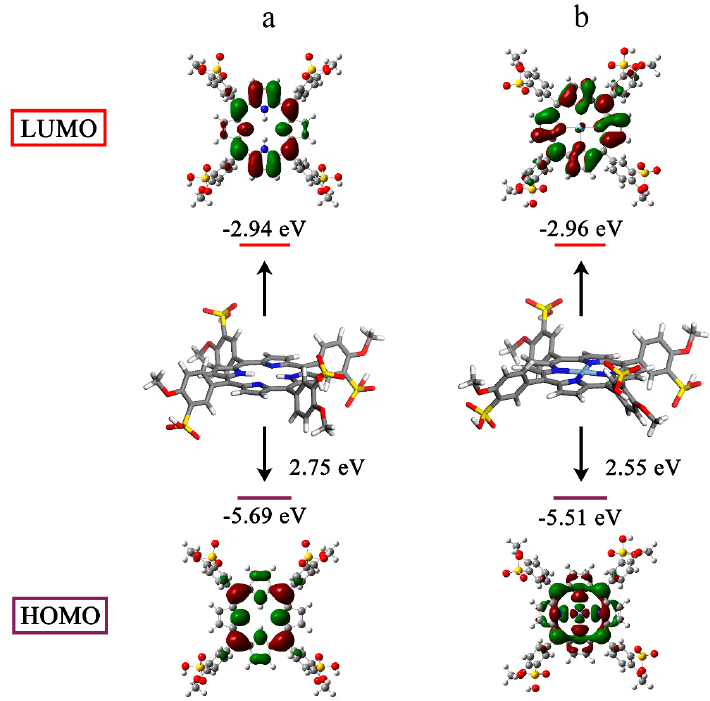
Figure 5. HOMO-LUMO profiles and energies of TMPPS ( a ) and AgTMPPS ( b ) determined by DFT. All calculations were performed at the DFT/TDDFT/B3LYP/6-311G(d)/LANL2DZ level of theory.